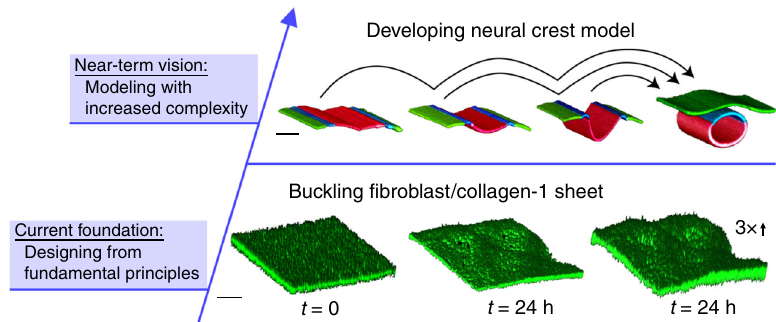
Fig. 7 Outlook for cell-driven and shape-changing 3D structures. To expand our approach beyond the microbeam, we created sheets made from cells and collagen-1, fi nding that they too exhibited a buckling instability (bottom row). Confocal micrographs show a fl at sheet immediately after printing (left) and a buckled sheet 24 h after printing (middle; right image stretched 3× vertically to accentuate undulations. Scale bar: 500 μ m). We hope to one day create 3D versions of textbook-level models of developing tissues from multiple cell types. We demonstrate the readiness of the fabrication technique by printing static models of a neural crest tube at different stages of development, made of microspheres that fl uoresce in three different colors. Confocal micrographs show the four structures, all made from three different materials (Scale bar: 2 mm; See Supplementary Information on 3D printed neural